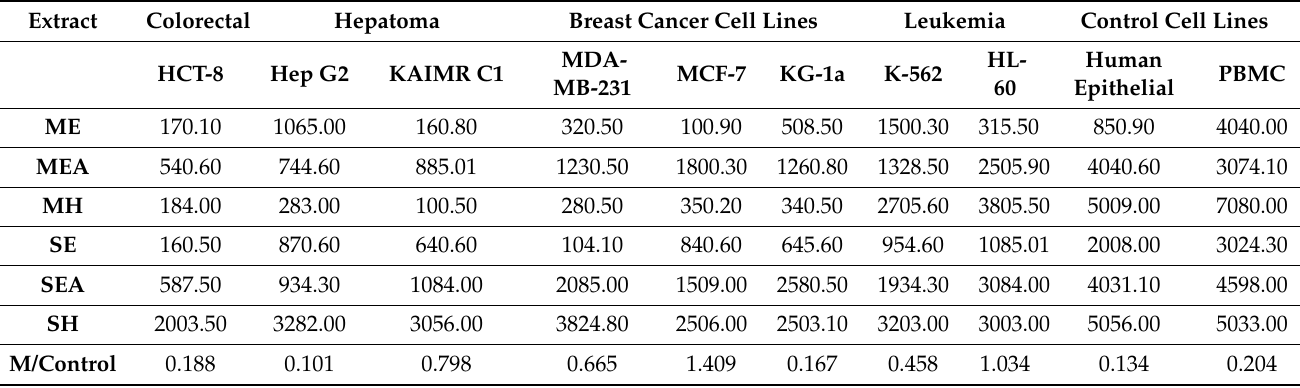
Table 3. IC 50 values ( µ g/mL) exhibited by the C. lentillifera on different cancer (colorectal, hepatoma, breast, leukemia, and normal (monocular blood and epithelial) cell